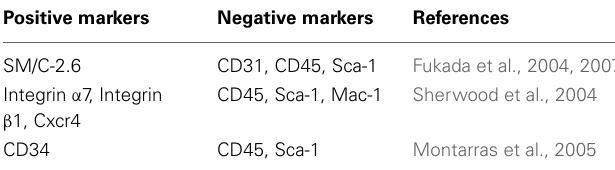
Table 1 | Markers used in the direct isolation of muscle satellite